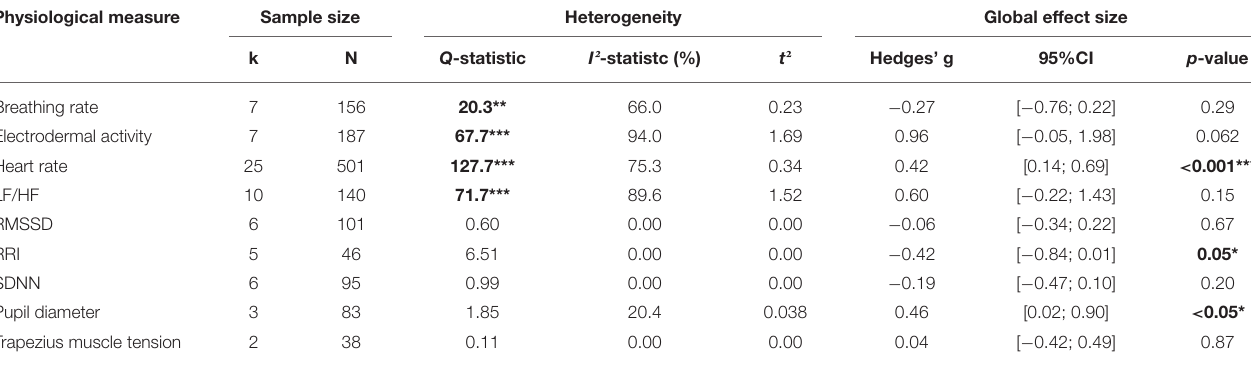
TABLE 1 | Outcomes of the meta-analyses. Physiological measure